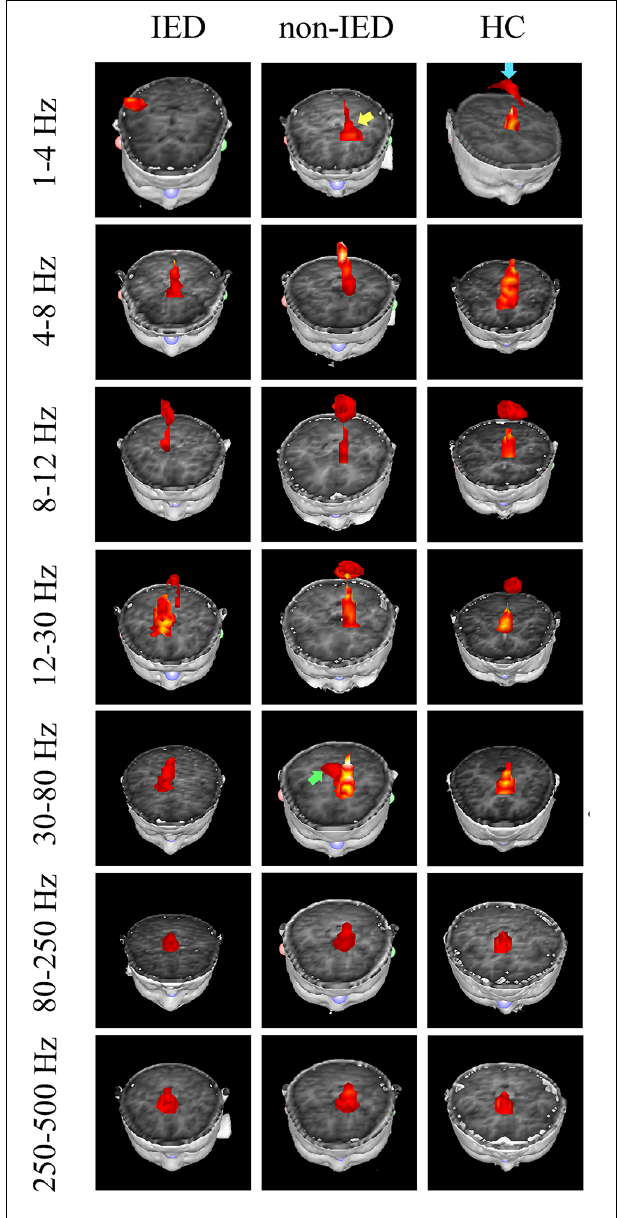
FIGURE 2 | Magnetic source images showing intrinsic brain activity in a 1–500 Hz frequency range in three groups. The yellow arrow points to the region which shows a significant difference between the benign epilepsy with centrotemporal spikes (BECTS) patient with and without IEDs. Blue arrow points to the region that shows the activation in the control but not in the patient with IEDs. The green arrow indicates the predominant neuromagnetic activity between the BECTS without IEDs and the